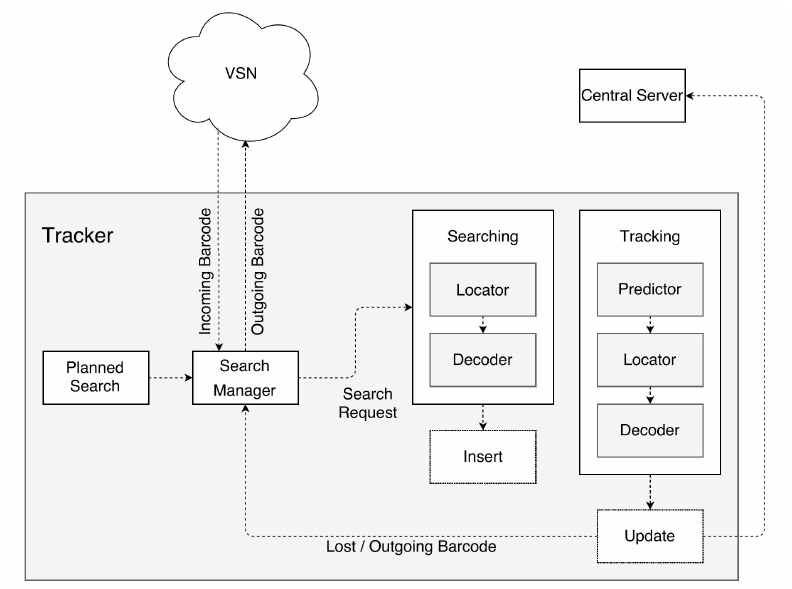
Figure 8. Workflow of barcode tracking